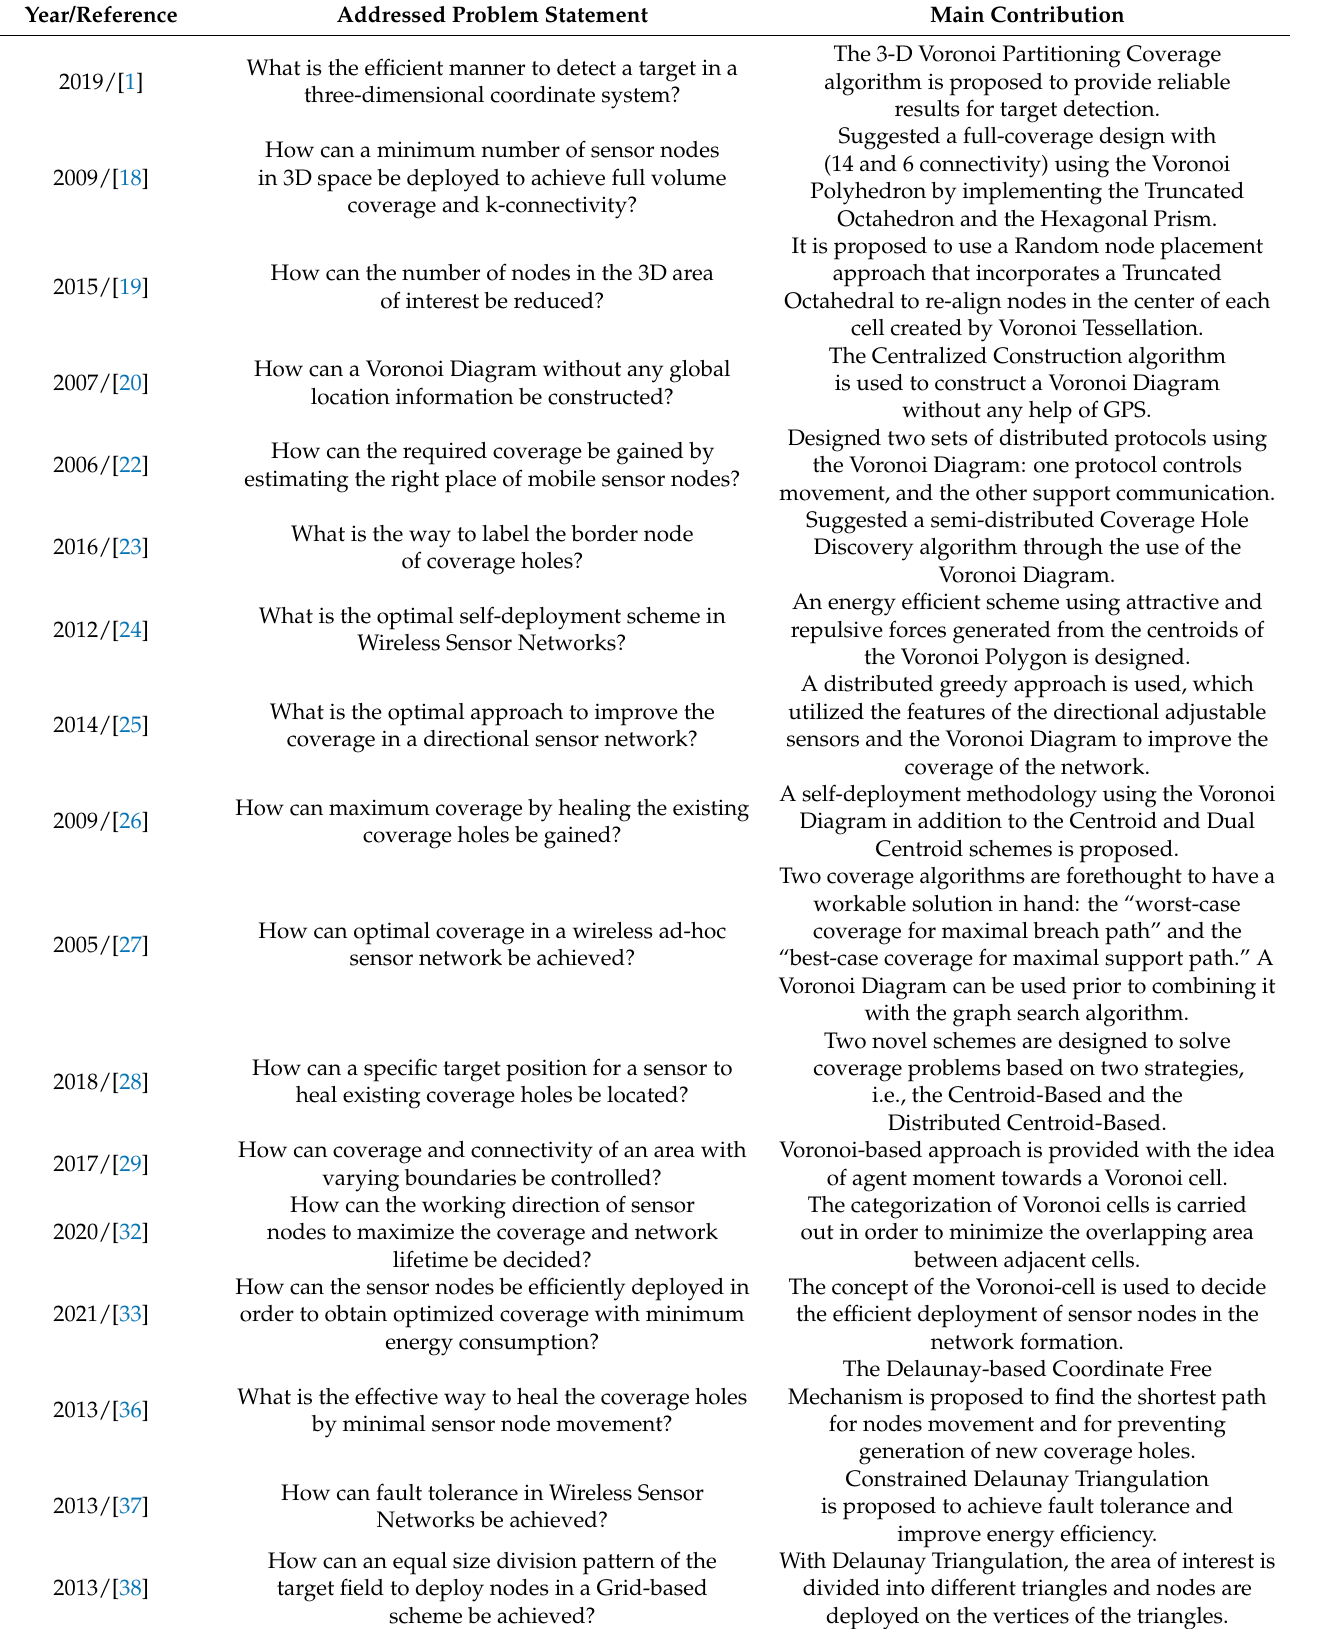
Table 6. Summary of various Problem Statements and the corresponding solution/contribution of by various